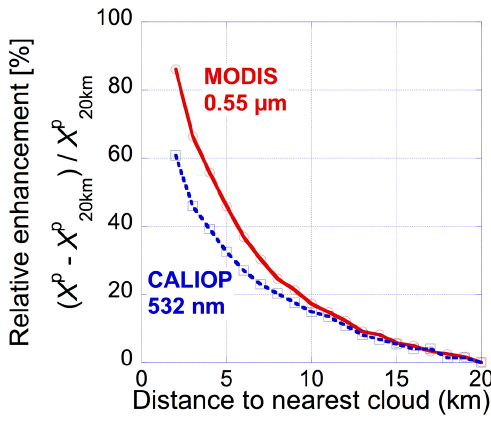
Fig. 4. Median near-cloud relative enhancements in particle scat- tering observed by MODIS and CALIOP over all oceans between 60 ◦ N and 60 ◦ S. Relative enhancements (RE) are calculated using the equation RE = 100 ( X − X 20km ) / X 20km , with X being R p or β p for the two